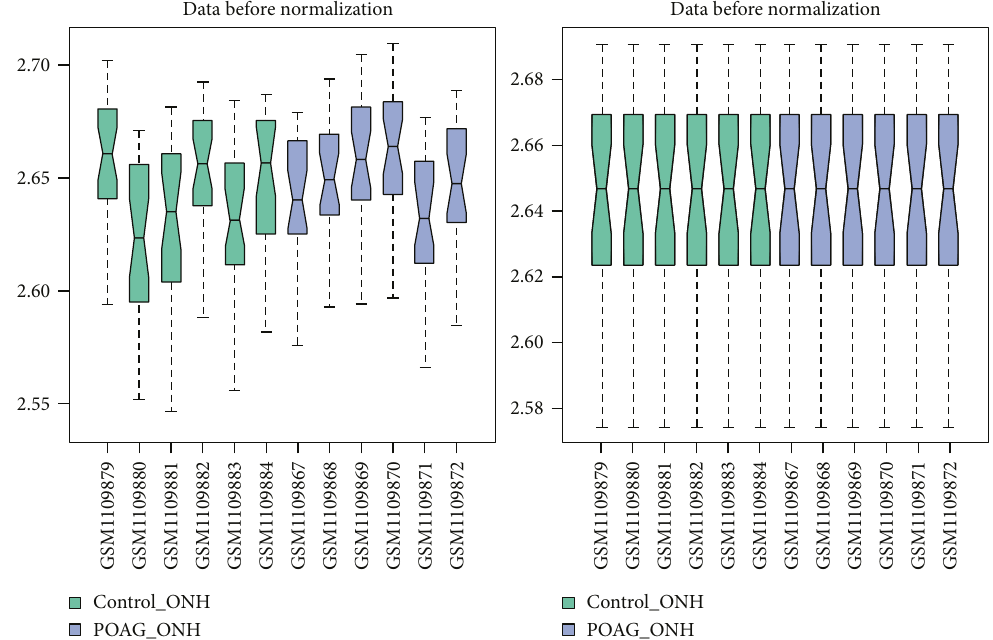
Figure 1: Microarray chips